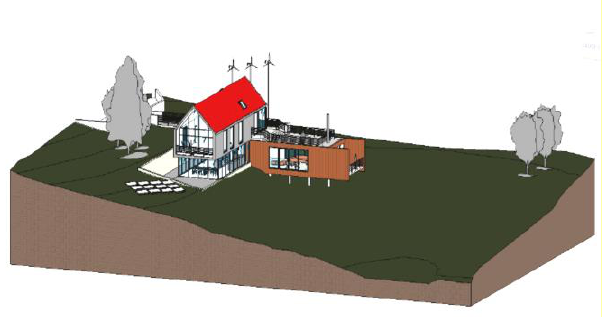
Figure 1. The BIM